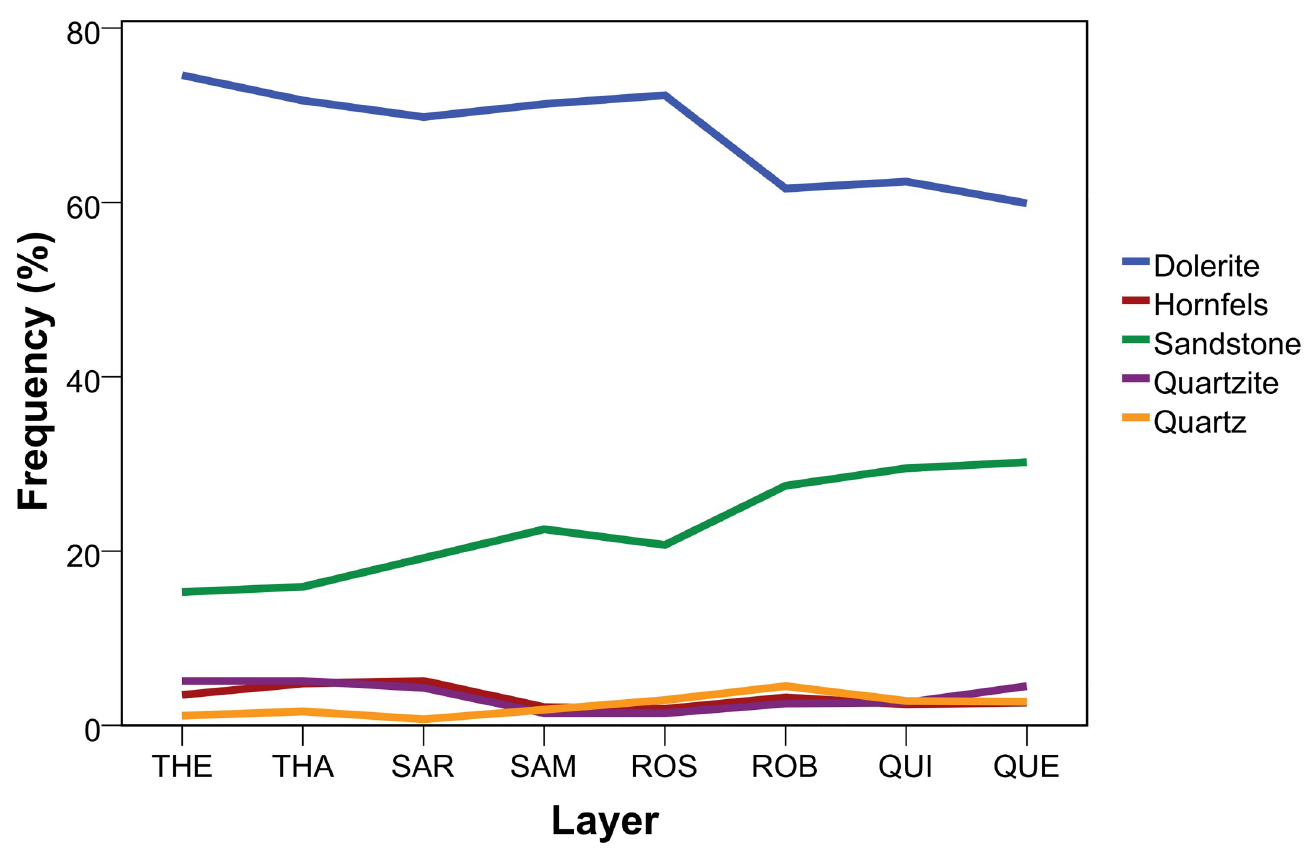
Fig 2. Diachronic variation of raw materials throughout the HP at Sibudu. THE = oldest layer; QUE = youngest layer. https://doi.org/10.1371/journal.pone.0239195.g002 (Fig 2; Table 3). Dolerite reaches a peak in the lowermost assemblages (THEODORA-THABO; 75–72%) followed by a slight decline in the middle part of the sequence (SARAH-ROSA; 72– 70%), and the lowest value for the uppermost layers (ROBERT-QUENTIN; 62–60%). Sand- stone shows a diametrically opposed pattern with a steady increase throughout the sequence and the lowest values at the bottom (15–16%) compared to the uppermost assemblages (QUINCY-QUENTIN: ~30%). The diachronic trends in both raw materials follow a signifi- cant monotonic relationship (dolerite: τ = -0.643, p = 0.026; n = 8; sandstone: τ = 0.929, b b Table 3. Raw material distribution for lithic debitage > 30 mm (n) by layer for the Sibudu HP. Layer Dolerite Hornfels Sandstone Quartzite Quartz CCS/Other